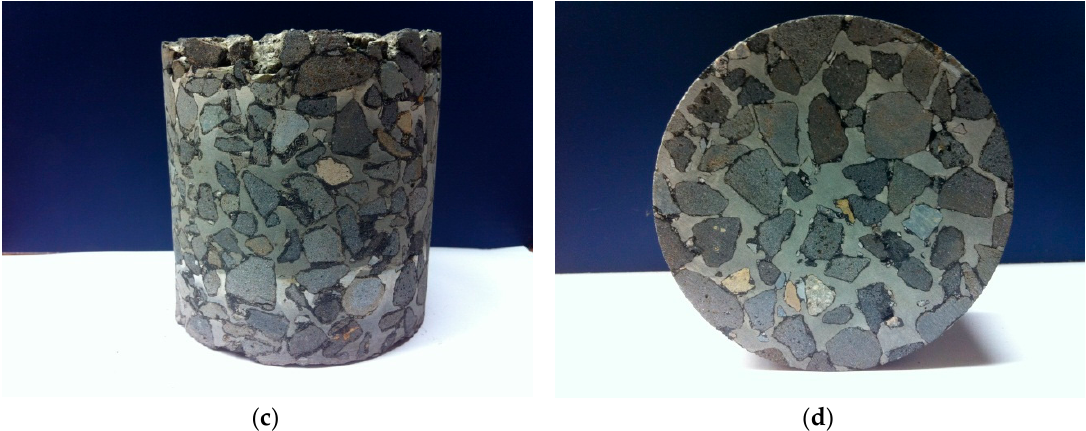
Figure 3. Sample before and after sawing. ( a ) Sample coring, ( b ) slab sample after coring, ( c ) sample before sawing, ( d ) sample after sawing.